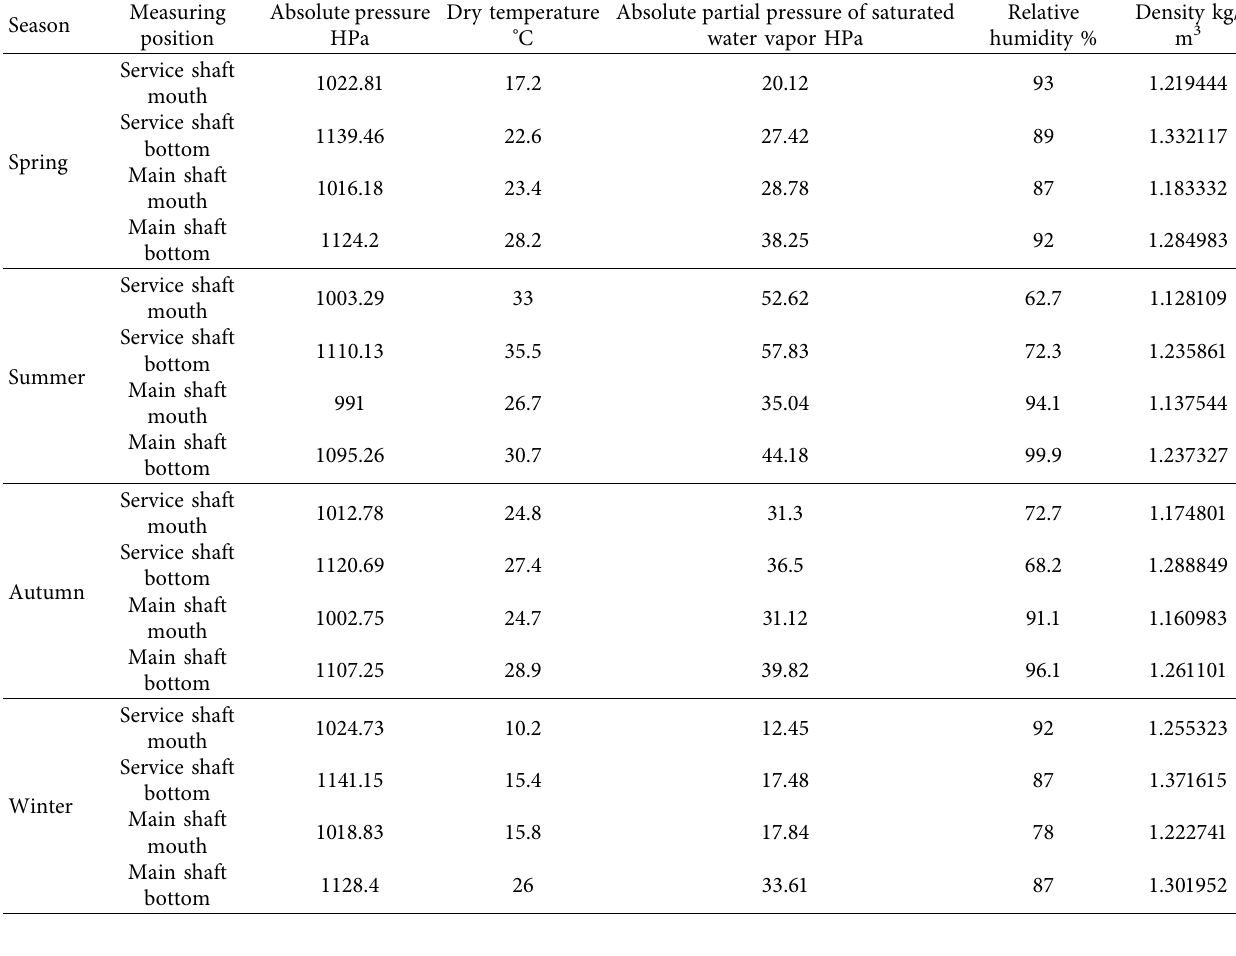
Table 1: Measured data of four seasons in shaft